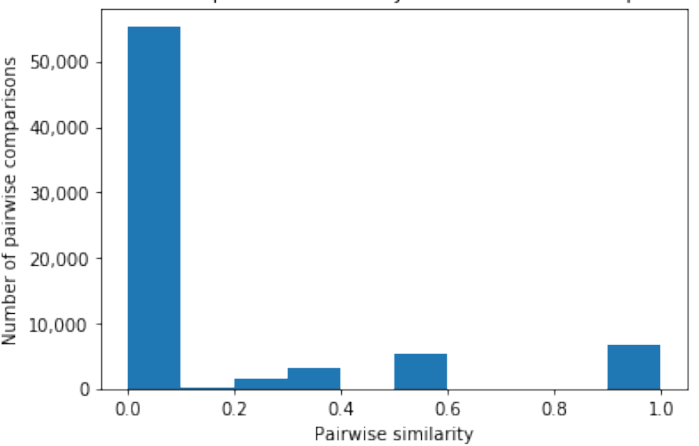
Figure 7. Distribution of pairwise similarity between counterfactual explanations for predicting Neuroticism. A value of 0 (resp., 1) indicates no (resp., perfect) overlap. When explaining the predictions for the personality trait of Neuroticism, 91.1%